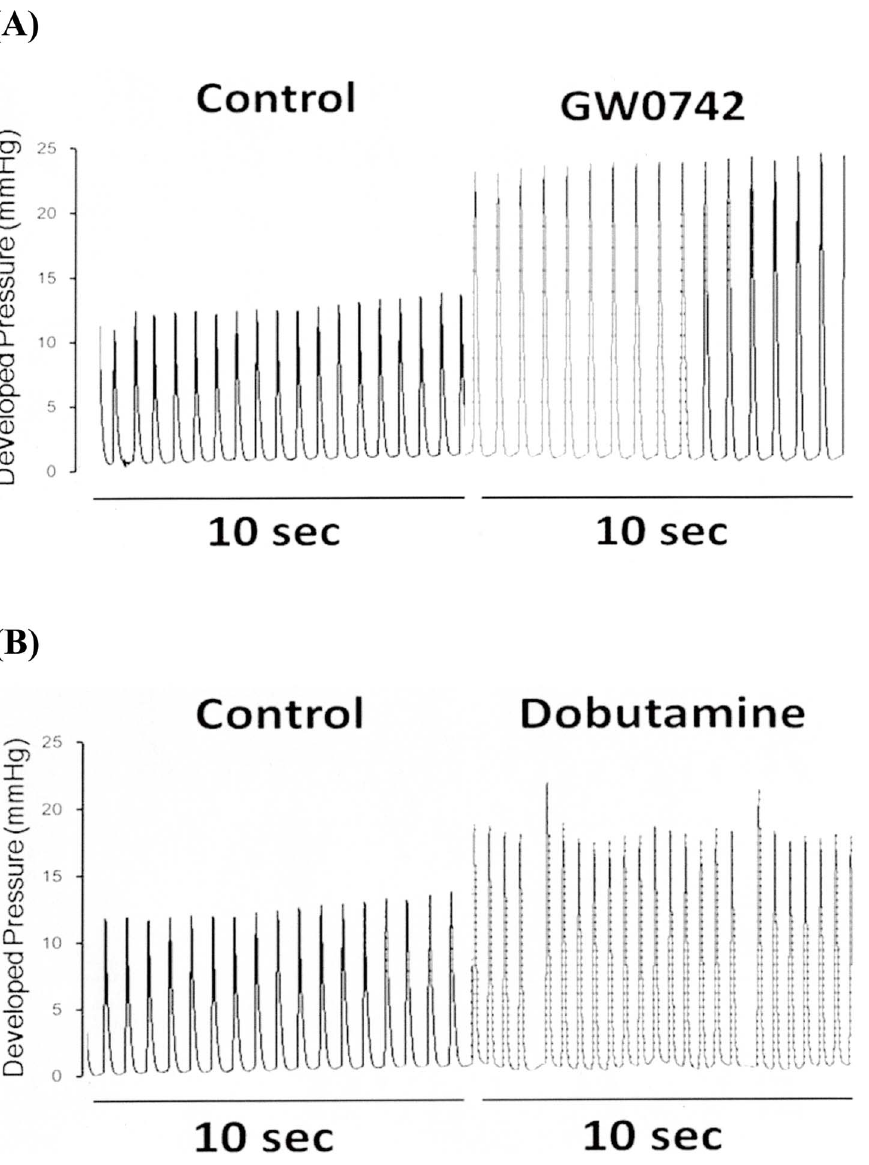
Figure 1. Effects of GW0742 and Dobutamine on Cardiac Performance in Hearts Isolated from Rats. The representative picture shows the change in cardiac performance caused by GW0742 (A) or dobutamine (B) in isolated hearts. Heart rate and cardiac contractility were recorded before and after the perfusion of the test agents.